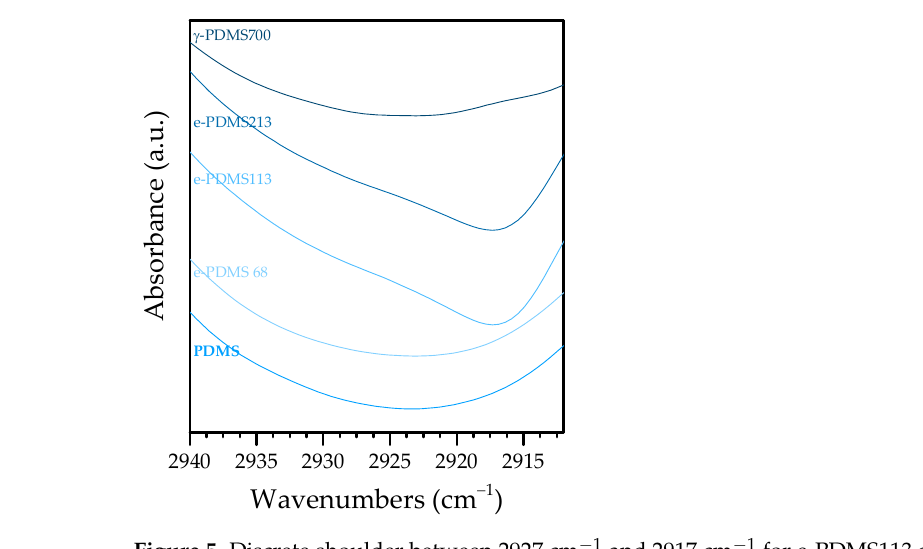
Figure 5. Discrete shoulder between 2927 cm −1 and 2917 cm −1 for e-PDMS113 and e-PDMS-213. The fact that the presence of —CH2— groups occurs for e-PDMS113, e-PDMS213 and γ-PDMS700 strengthens the hypothesis of the gel point being in the previously mentioned range of 68–113kGy, meaning that a dose lower than 113 kGy would not be sufficient to induce radiolysis of methyl groups and subsequent recombination and cross-linking.